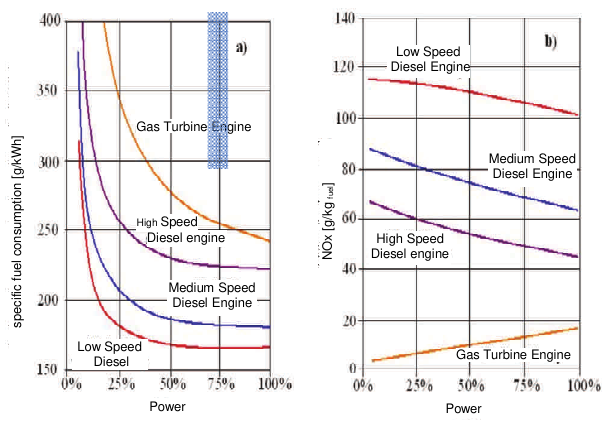
Fig. 1. Specific fuel consumption (a) and NO x (b) as a function of the power used for the propulsion types of compression-ignition and gas